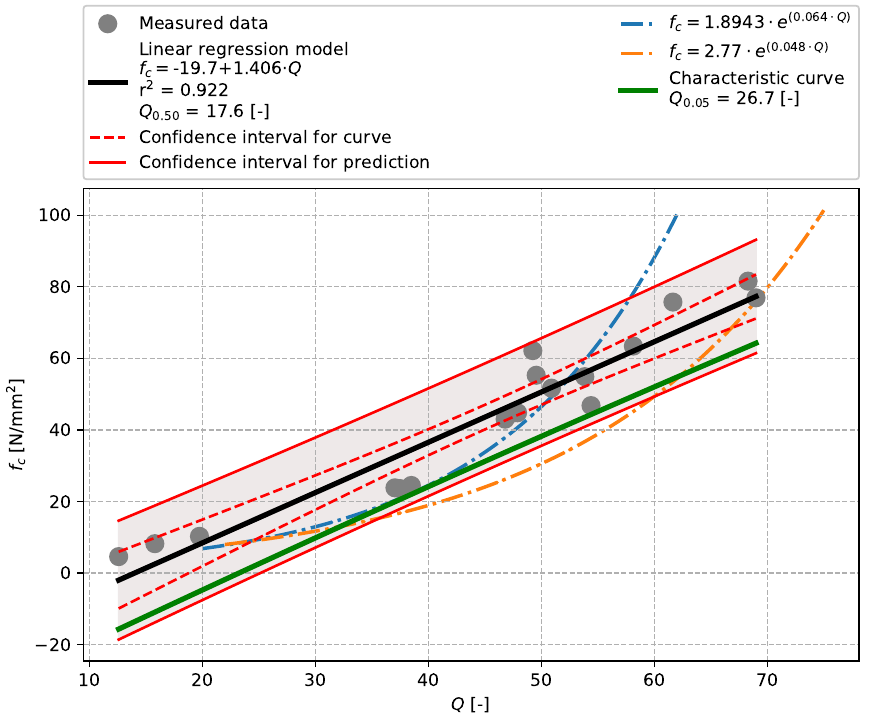
Figure 8. Precast concrete described in Section 3.2—model of the dependence of Q -value [-] vs. compressive strength f c [N/mm 2 ]—SilverSchmidt